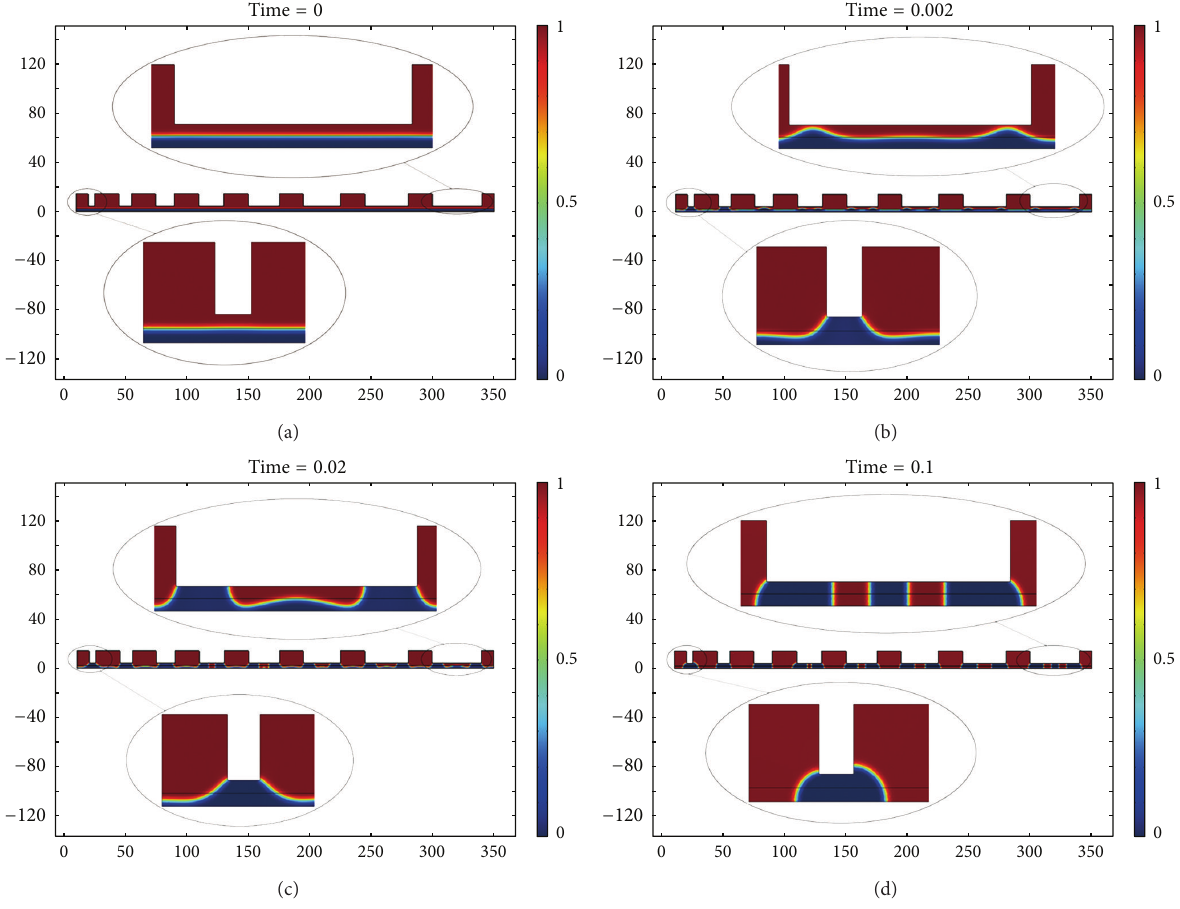
Figure 7: The evolution process of EHD patterning experiment with the highest spacer (4.0 𝜇 m). (a) The initial stage of EHD patterning, (b) and (c) the evolutionary stage of EHD patterning, and (d) the final stage of EHD patterning.